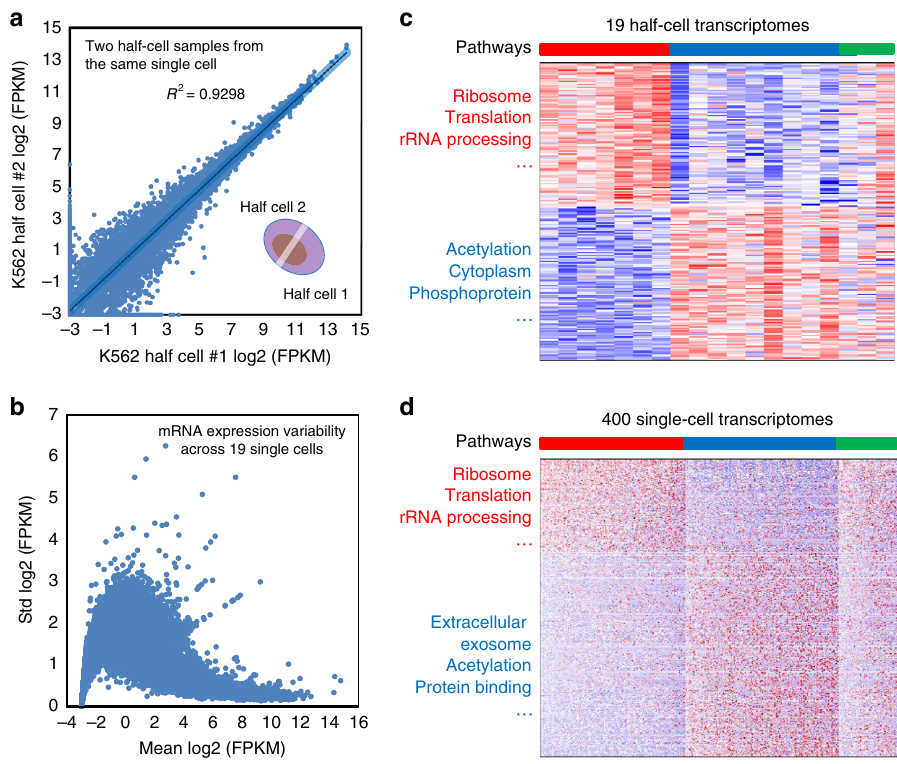
Fig. 3 Global pro fi ling of mRNAs from half cells. a A single K562 cell was lysed, and two halves of the lysate were separately subjected to RNAseq. Scatter plot of normalized and log2-transformed mRNA expression levels (in FPKM units) is shown. Each circle represents one annotated mRNA. The correlation coef fi cient R 2 is 0.930. b The standard deviations of mRNA expression across 19 successfully pro fi led half cells were plotted against the mean expression, using log2-transformed mRNA expression data. Each circle represents one annotated mRNA. c Consensus clusters were identi fi ed in the 19 K562 half-cell mRNA expression data. A heatmap is shown for differentially expressed genes between the red and blue clusters, with enriched pathways annotated by the DAVID pathway analysis. Each row represents one annotated gene whereas each column represents a single cell. d K562 cells were pro fi led using a massively parallel single-cell 3 ′ -end RNAseq technology. A heatmap is shown for differentially expressed genes between the red and blue consensus clusters, with enriched pathways annotated by the DAVID pathway analysis. Each row represents one annotated gene whereas each column represents a single cell. Within the heatmaps, blue color indicates low expression whereas red indicates higher